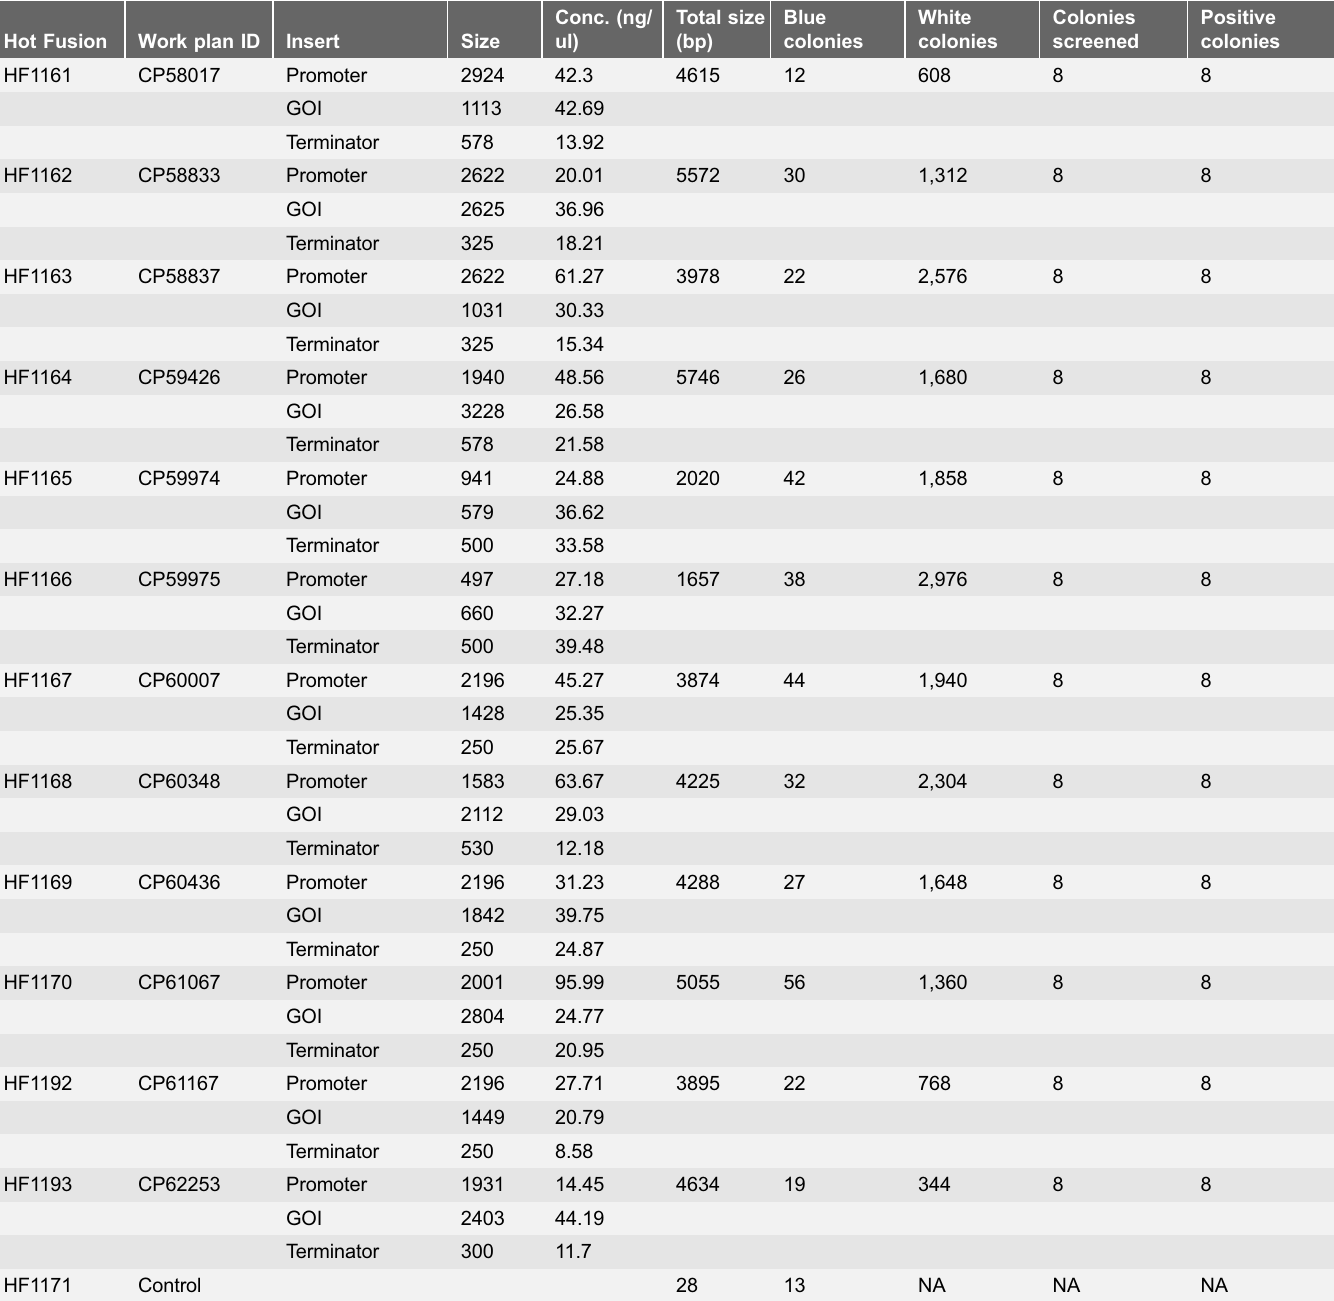
Table 3. One step assembly of promoter, GOI and terminator by Hot Fusion reaction. Hot